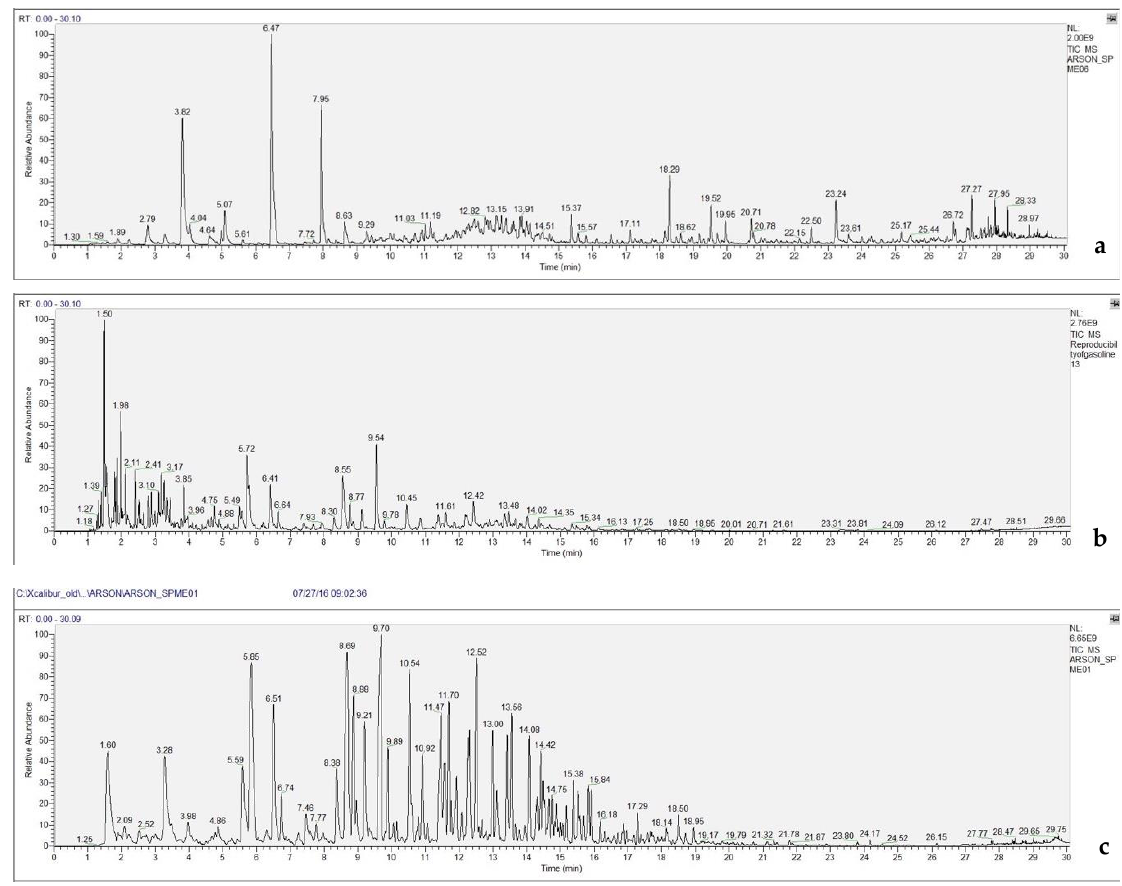
Figure 3. Total ion chromatograms ( m / z 50–500) of ( a ) carpet #1, burned without ILs; ( b ) carpet #1 burned with gasoline; and ( c ) neat gasoline.